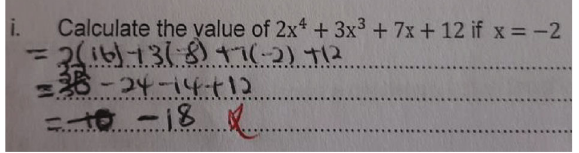
Figure 10: Learner AS, School